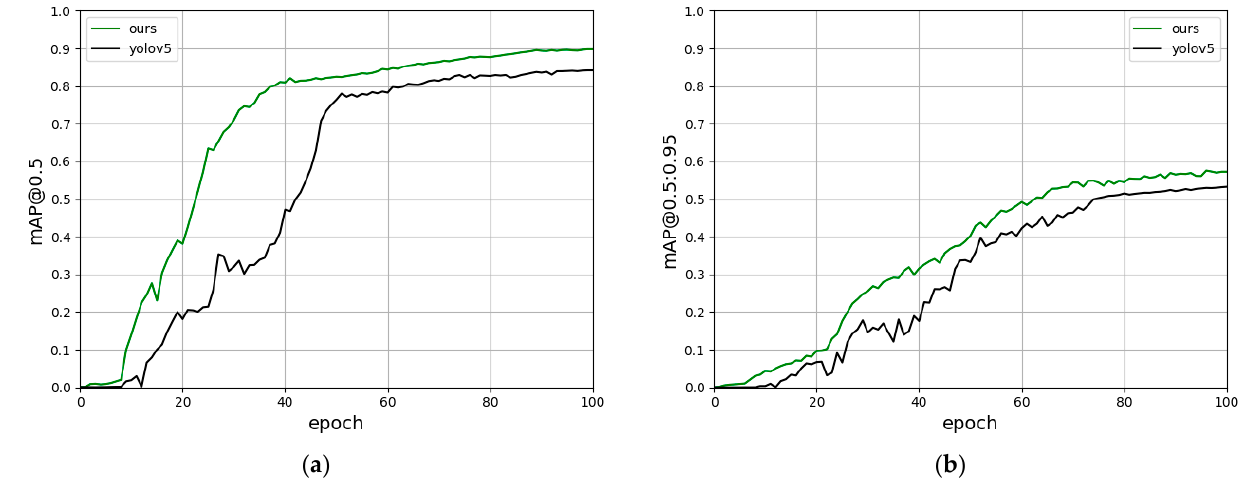
Figure 14. Comparison of the average precision value curve of the algorithm: ( a ) mAP@0.5; ( b ) mAP@0.5:0.95.